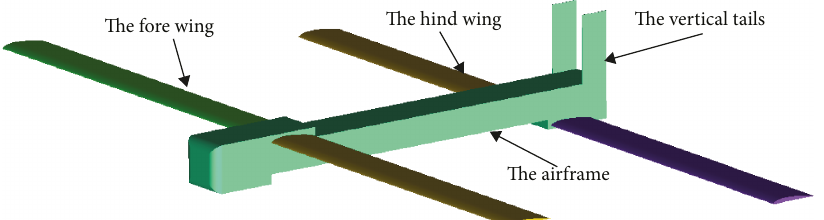
Figure 12: Model of tandem wing con fi guration with airframe.